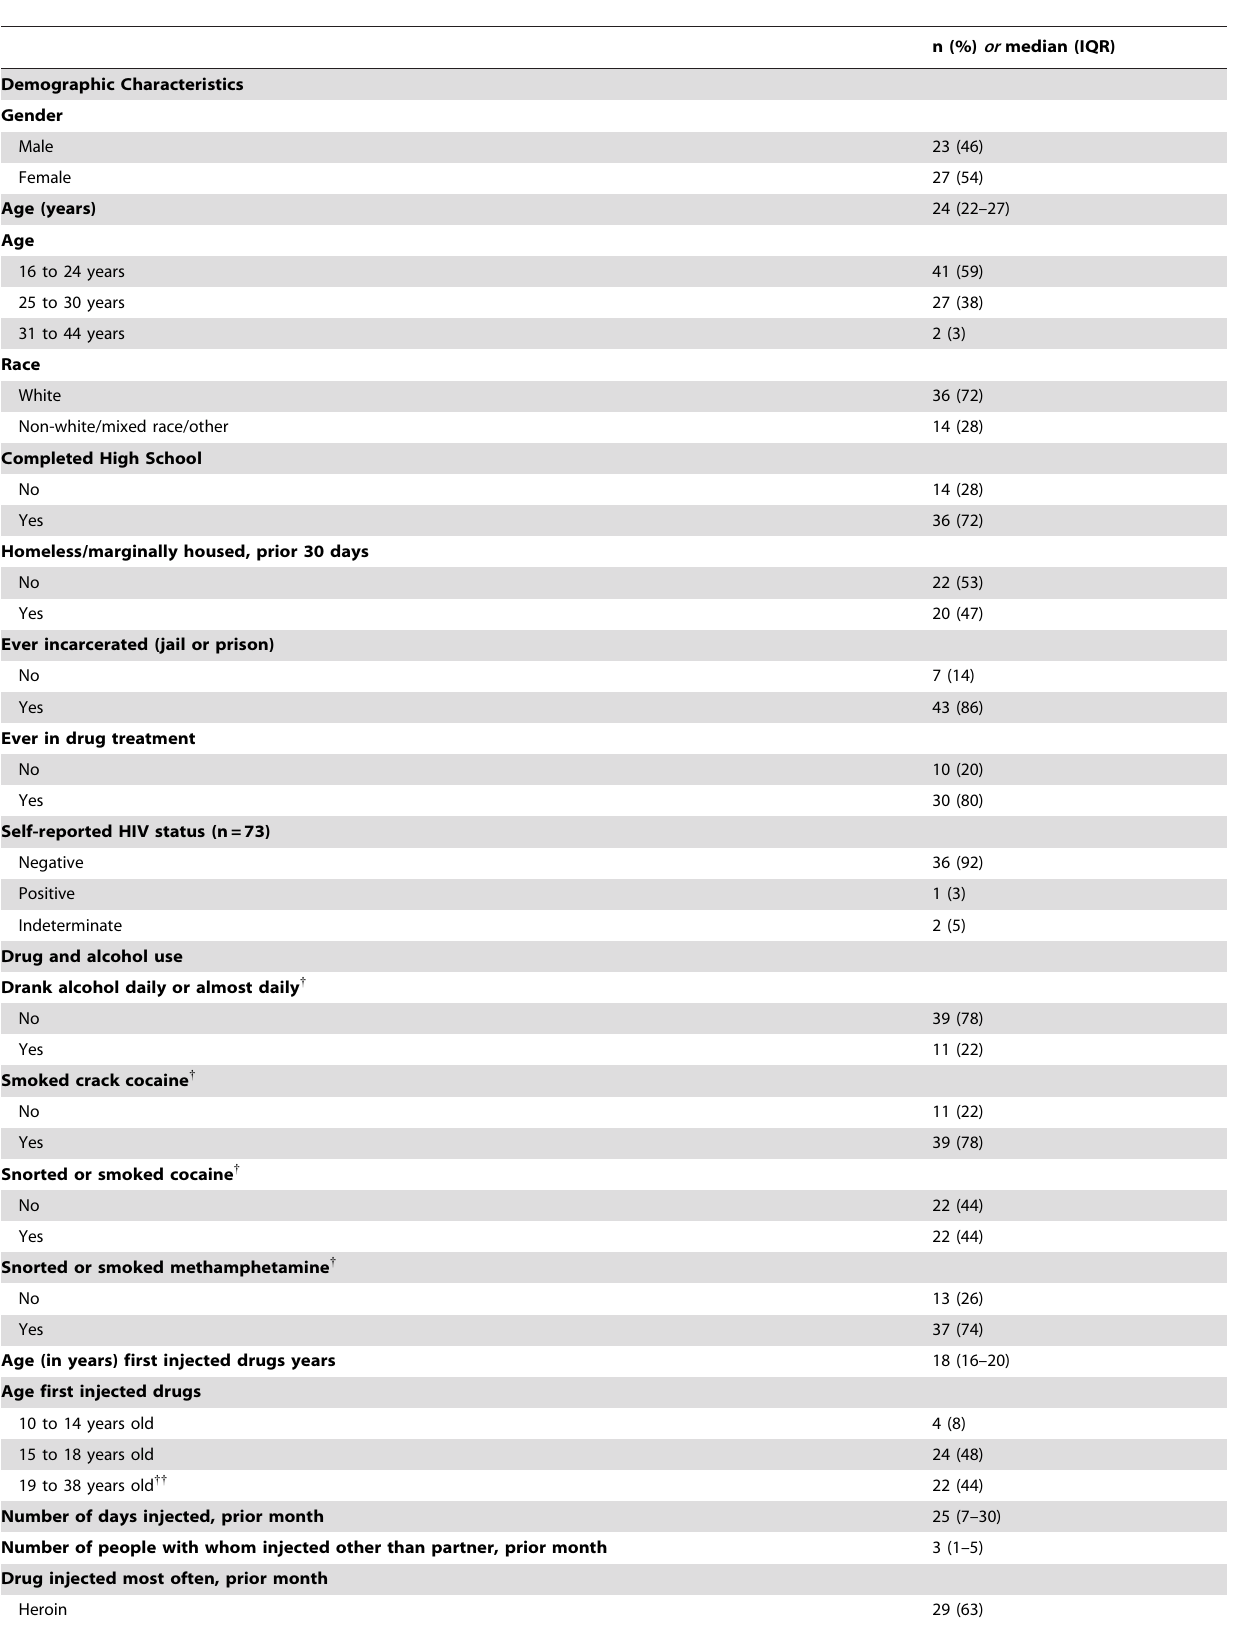
Table 1. Characteristics of the HCV-negative ‘‘at-risk’’ injection partner at enrollment (n=50) ` .